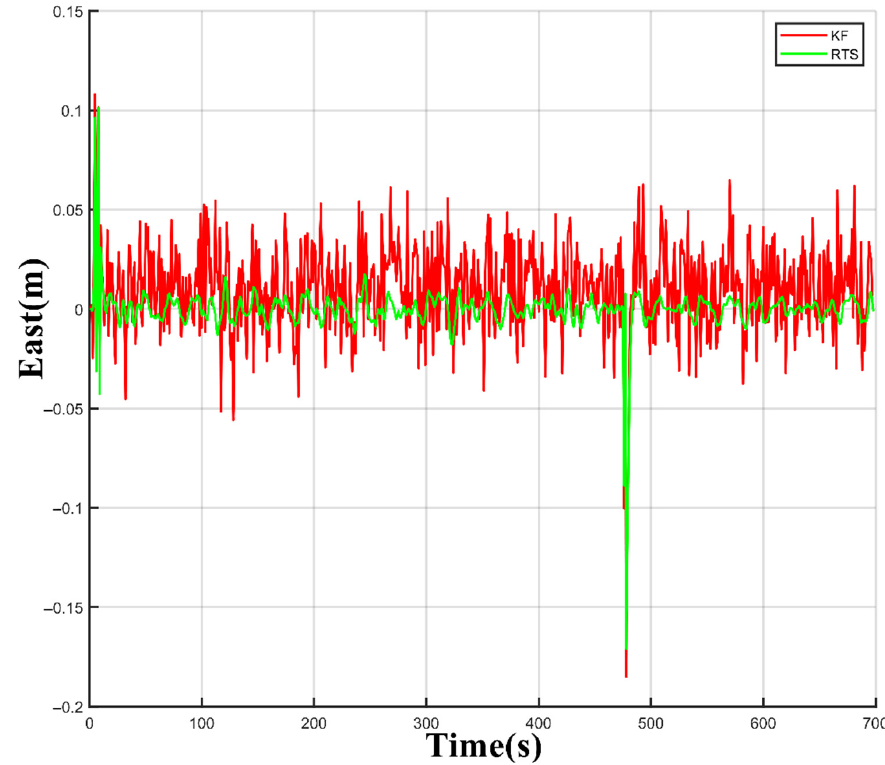
Figure 15. Comparison of eastward error between the KF and RTS.